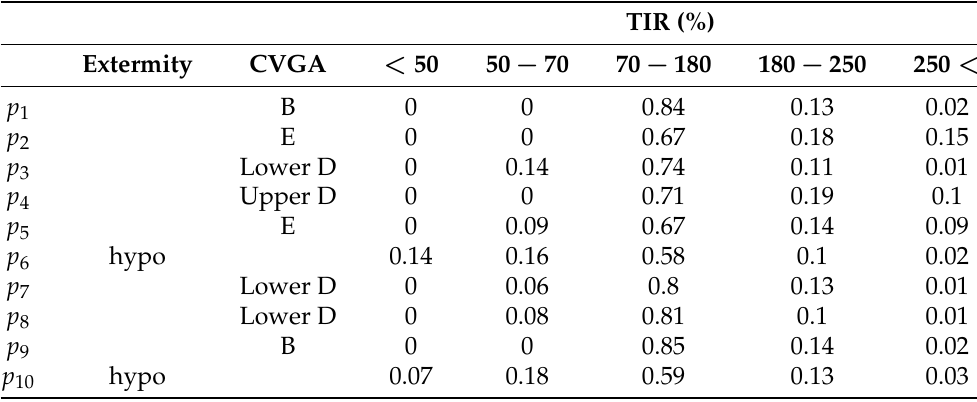
Table 3. CVGA and TIR metrics, corresponding to the slow